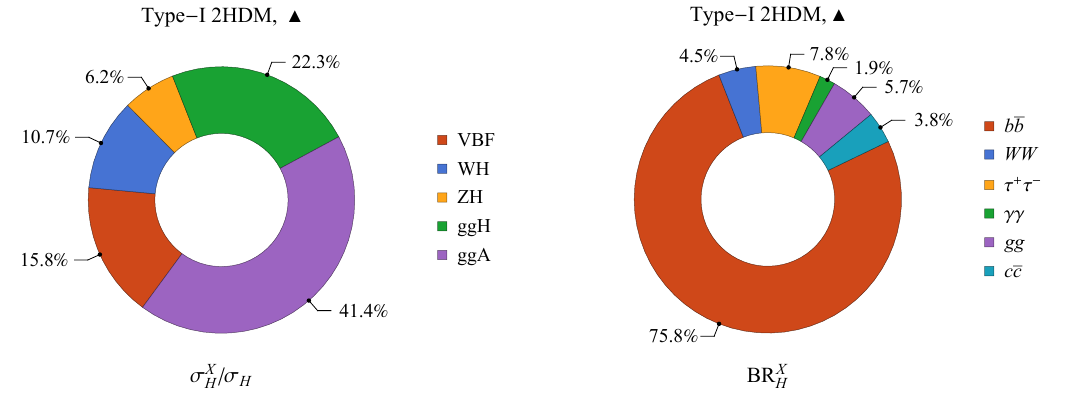
Figure 11 . As (cid:12)gure 2 but for the third type-I 2HDM benchmark scenario (3.3). The label \ggA" in the left panel refers to H production through gg ! A followed by A ! W (cid:7) H (cid:6) ! W (cid:7) W (cid:6) H . Apart from BR (cid:13)(cid:13) only values of (cid:27) X =(cid:27) H and BR X that exceed 2% are H H H